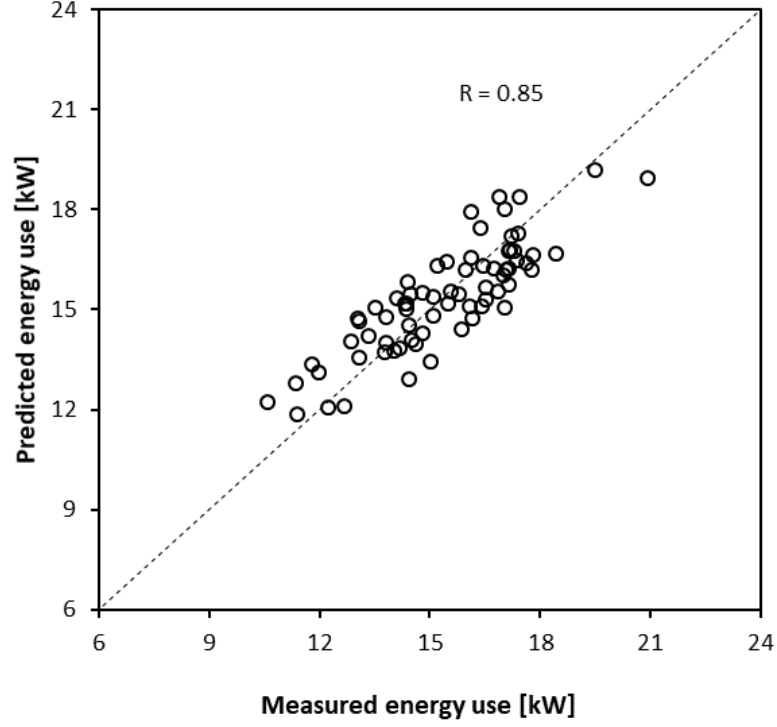
Figure 14. The predicted power consumption plotted against the measured power consumption for the validation dataset. The Pearson correlation coefficient is given as the